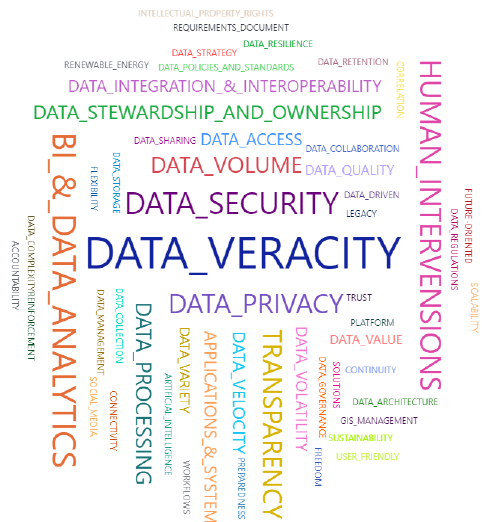
Figure 9 . Smart City Data Management